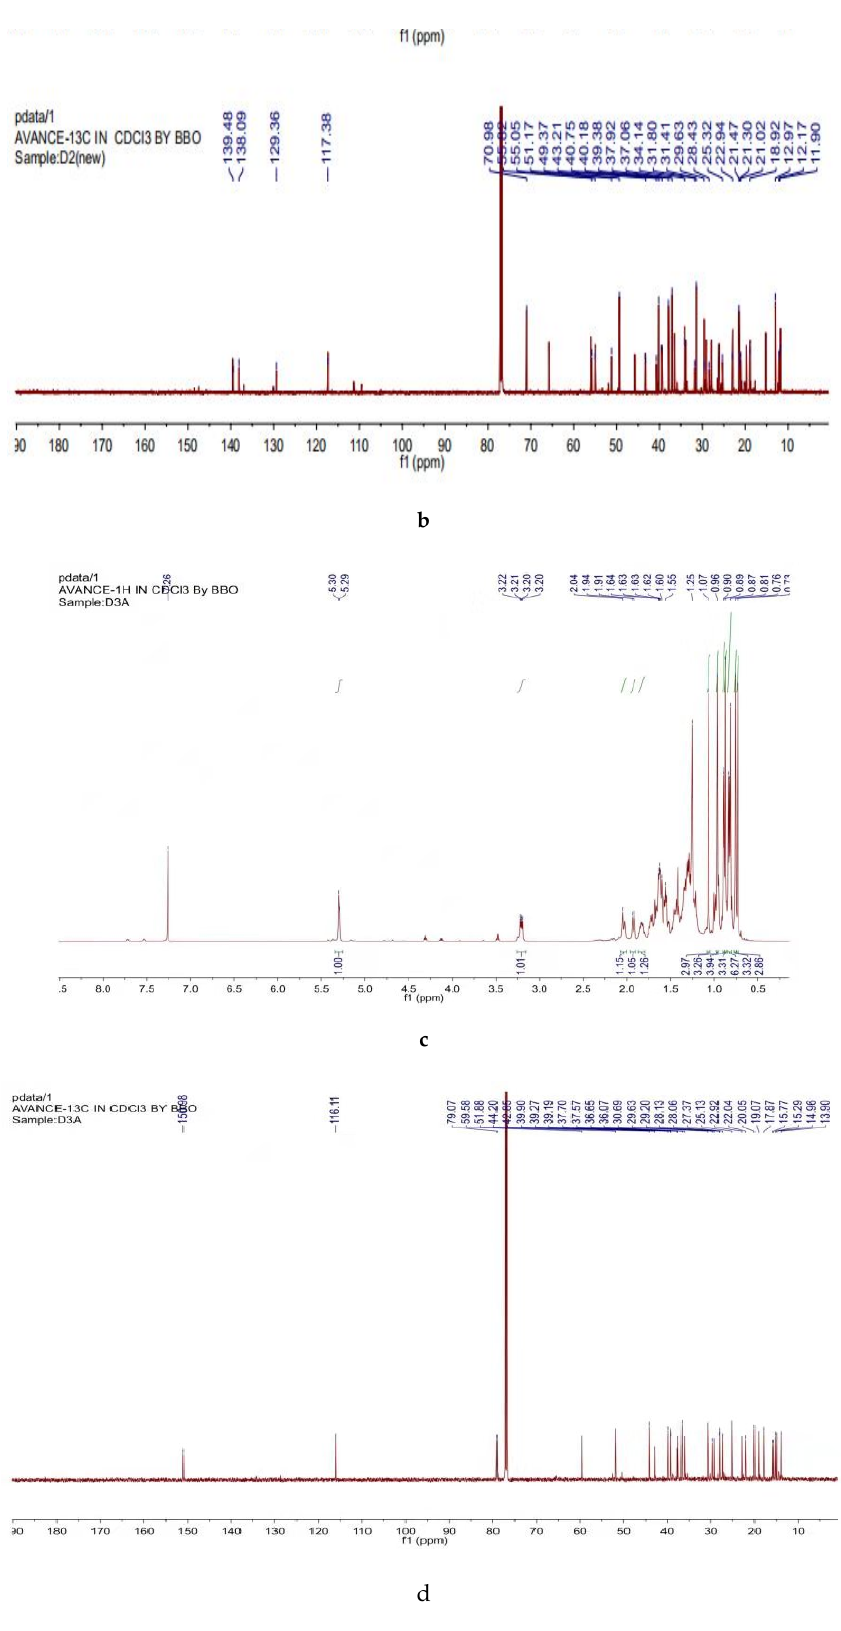
Figure 4. a 1 H-NMR spectrum of the compound D2 (N); b . 13 C-NMR spectrum of compound D2 (N); Figure 4. ( a ). 1 H-NMR spectrum of the compound D2 (N); ( b ). 13 C-NMR spectrum of compound D2 c . 1 H-NMR spectrum of the compound D3A d . 13 C-NMR spectrum of the compound D3A. (N); ( c ). 1 H-NMR spectrum of the compound D3A; ( d ). 13 C-NMR spectrum of the compound